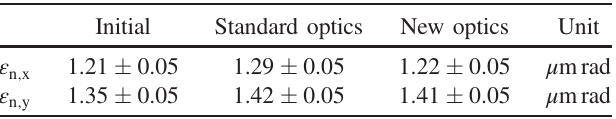
TABLE III. Transverse rms normalized emittances measured at the entrance ( “ Initial ” ) and at the exit of the FERMI spreader, for the standard and the new optics (see Fig. 6). Initial Standard